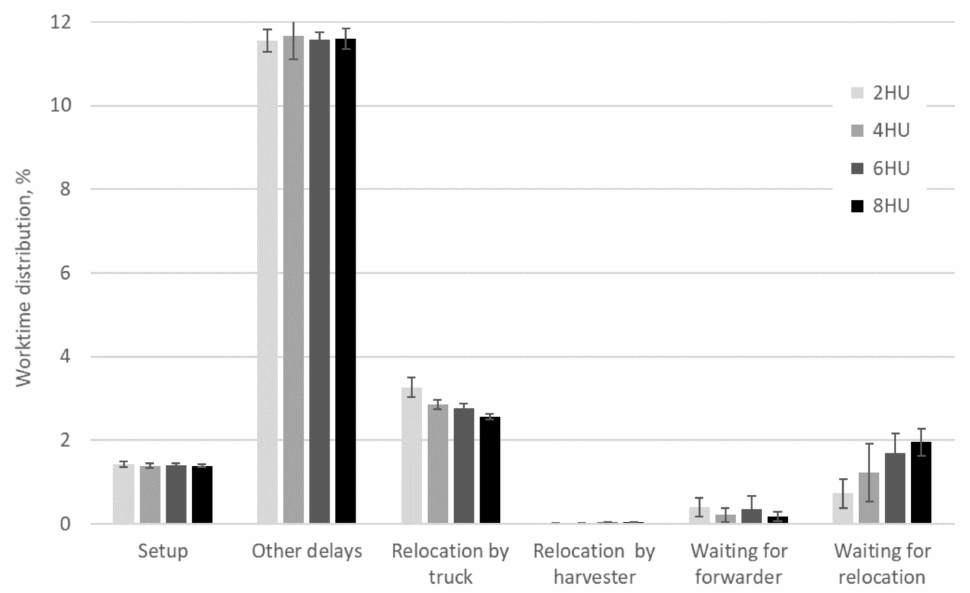
Figure 6. Worktime distributions for smaller time elements of harvesters with 95% confidence intervals. The entrepreneur’s fleet size ranged between 2 and 8 harvesting units (HU).